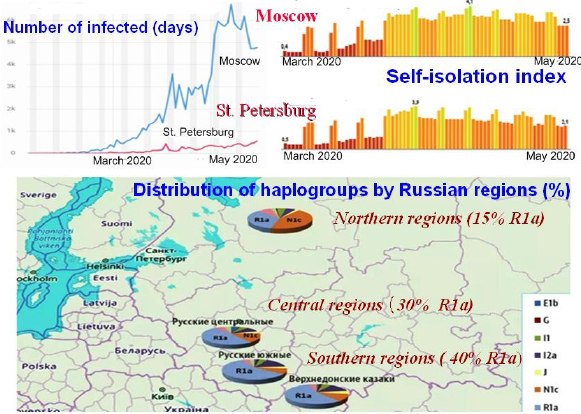
Figure 9. Local COVID-19 epidemics: Moscow and St. Petersburg (first wave) Top right – the number of infections in Moscow (blue curve) and St. Petersburg (red curve) from March to June 2020. Top left – the lockdown compliance index in Moscow and St. Petersburg from March to June 2020. Below is a population genetic map of the European territory of Russia.